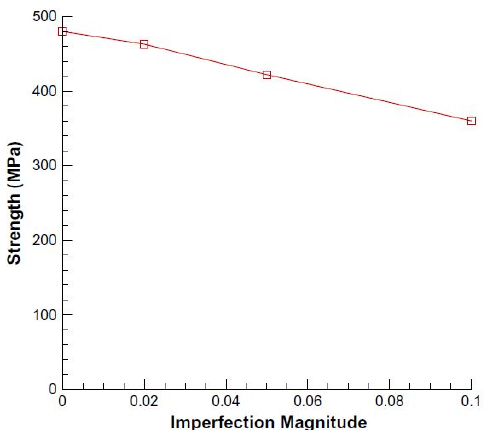
Figure 47. E ff ect of imperfection magnitude on compression strength of z-Pin composite (z-Pins, F igure 47. Effect of imperfection 1.0 vol%, d = 0.51 mm, [0]) magnitude on compression strength of z- F igure 46. Initial imperfection magnitude Pin composite (z-Pins, 1.0 vol%, d = 0.51 mm, [0]) [43]. h/l [43].